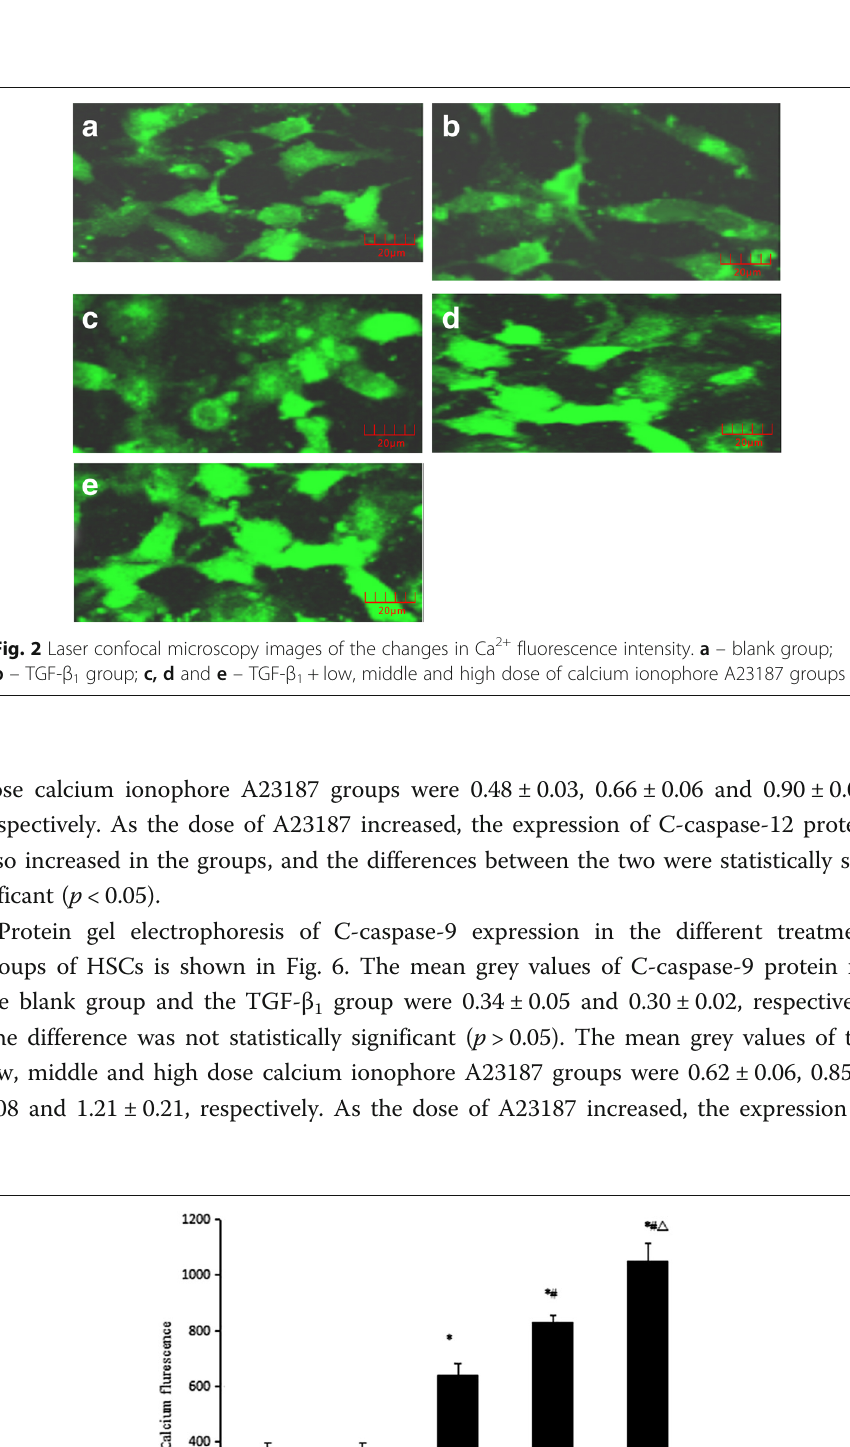
Fig. 3 Effect of different treatments on HSC calcium fluorescence. A – blank group; B – TGF- β 1 group; C, D and E – TGF- β 1 + low, middle and high dose of calcium ionophore A23187 groups. * p < 0.05 compared to the blank group; # p < 0.05 compared to the TGF- β 1 group; △ p < 0.05 compared to the TGF- β 1 + low dose of calcium ionophore A23187